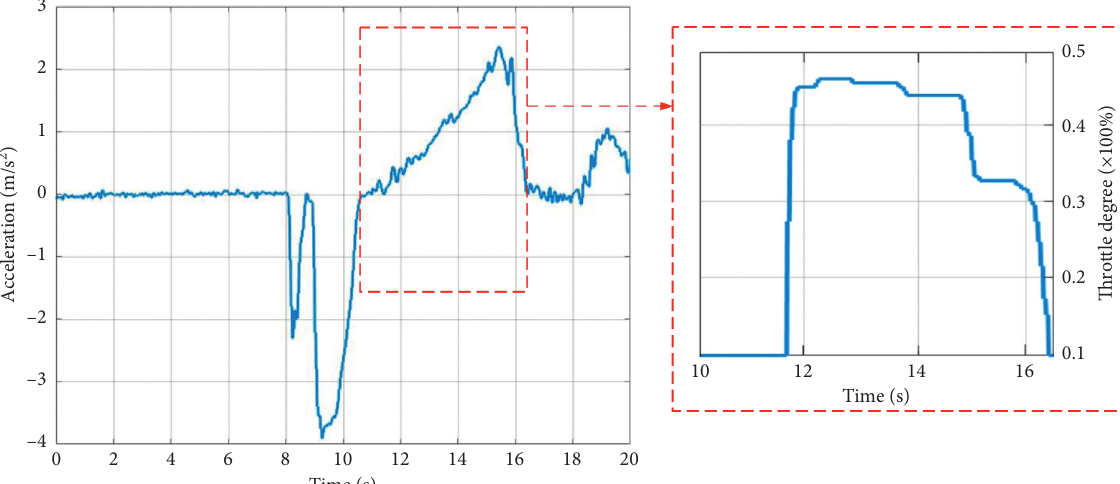
Figure 15: The acceleration and throttle degree for the real vehicle experimental